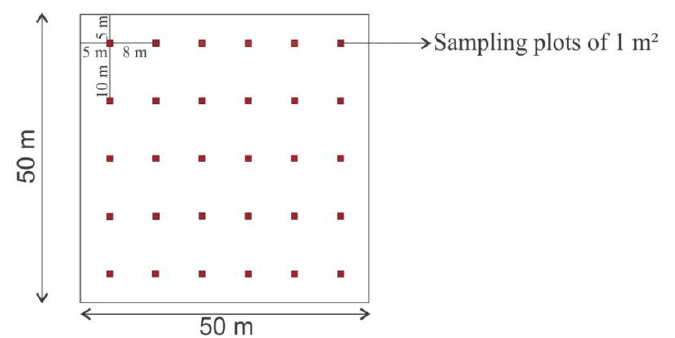
Figure 1. The arrangement of sample plots in the experimental field of 0.25